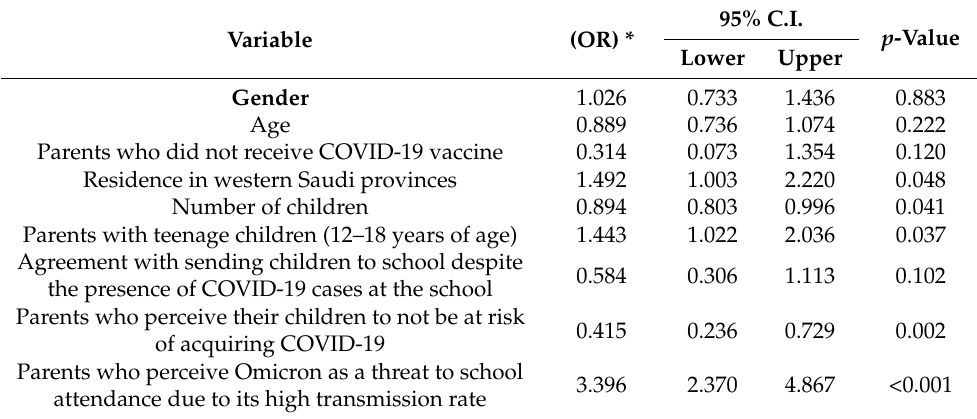
Table 3. Multivariable logistic regression analysis of parents’ odds of higher worry from the Omicron variant compared to the Delta